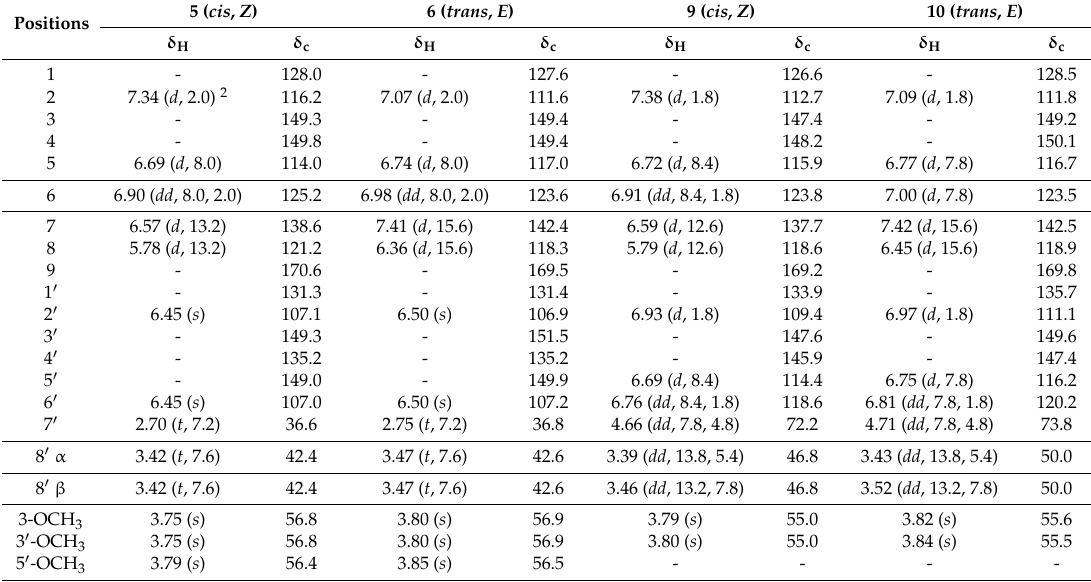
Table 1. 1 H and 13 C-NMR data for compounds 5 , 6 , 9 and 10 1